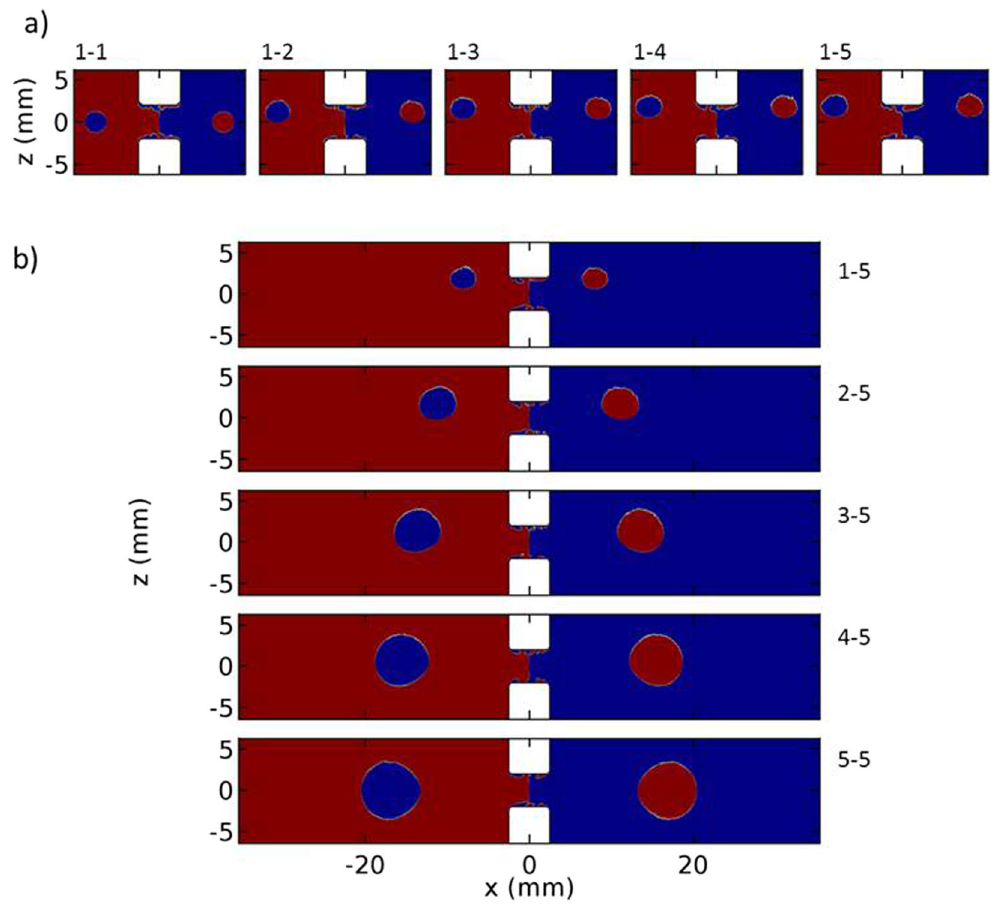
Figure 6. Dependence of the size and position of the elliptical regions of opposite F x on the magnetic configuration asymmetry for cases of ( a ) 1–1, 1–2, 1–3, 1–4, and 1–5 and ( b ) 1–5, 2–5, 3–5, 4–5, and